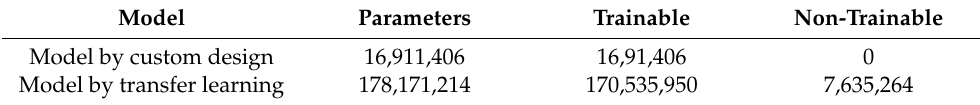
Table 8. Comparison of the two proposed models in terms of number of